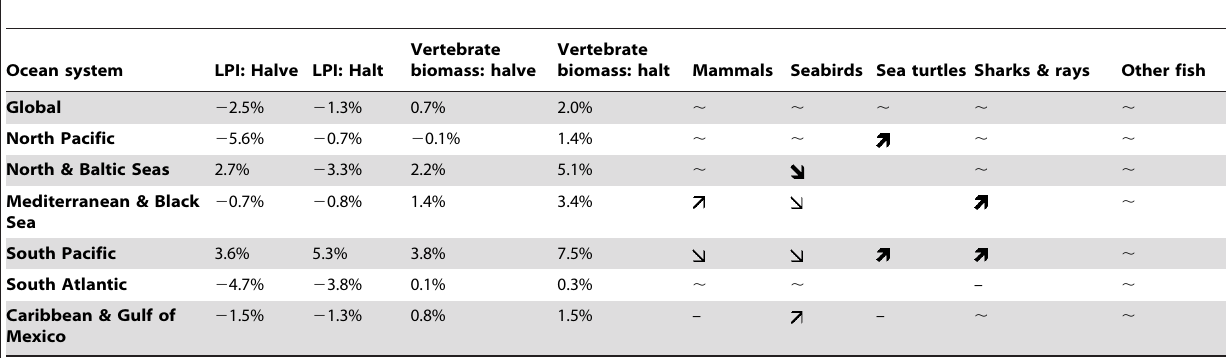
Table 1. The impact on the Living Planet Index (LPI) of halving or halting bottom trawling in six ocean systems, based on biomass trends in modelled vertebrate groups represented in the LPI.